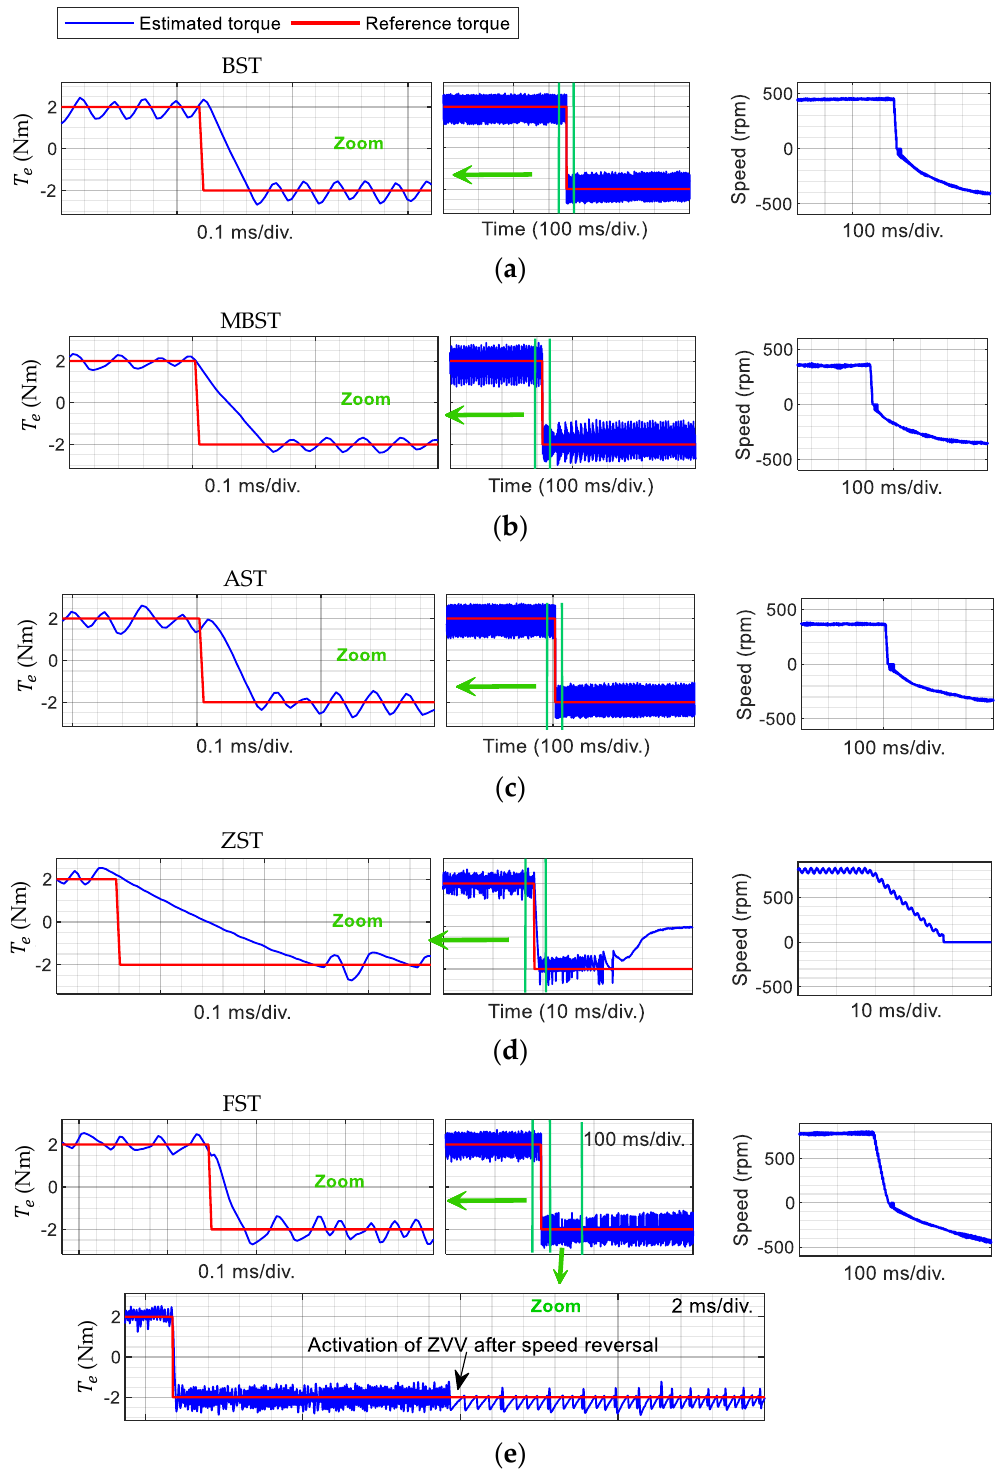
Figure 9. The torque dynamic response and the corresponding speed response for step change in the reference torque from 2 to − 2 Nm for the di ff erent STs: ( a ) BST; ( b ) MBST; ( c ) AST; ( d ) ZST; and ( e ) FST.